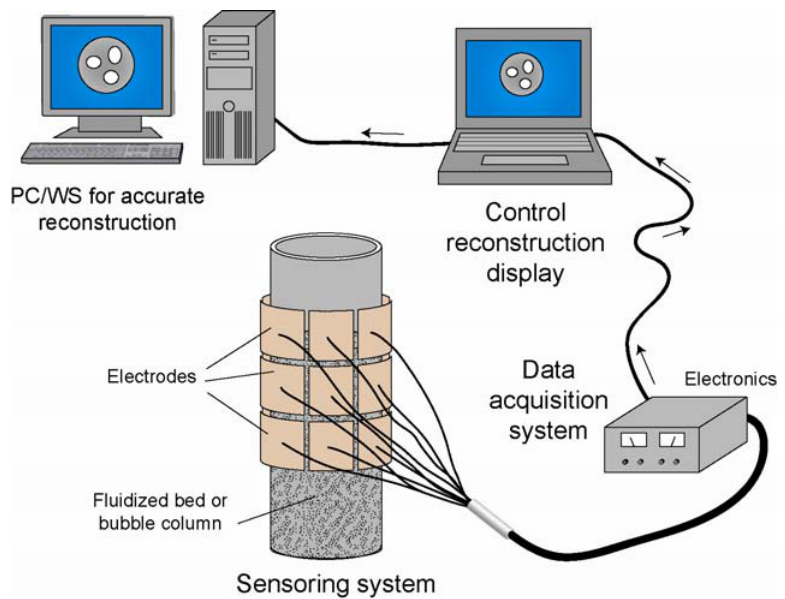
Figure 1. Sketch of an ECVT